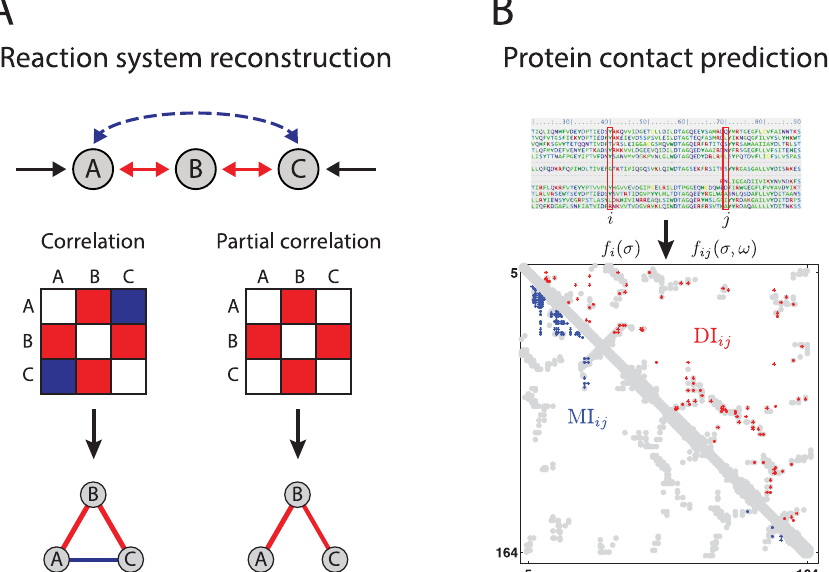
Fig 1. Reaction system reconstruction and protein contact prediction. Association results of correlation- based and maximum-entropy methods on biological data from an in silico reaction system (A) and protein contacts (B). (A) Analysis by Pearson ’ s correlation yields interactions associating all three compounds A, B, and C, in contrast to the partial correlation approach which omits the “ false ” link between A and C. (Fig 1A based on [21].) (B) Protein contact prediction for the human RAS protein using the correlation-based mutual information, MI, and the maximum-entropy based direct information, DI, (blue and red, respectively). The 150 highest scoring contacts from both methods are plotted on the protein contacts from experimentally determined structure in gray. (Fig 1B based on [6].)